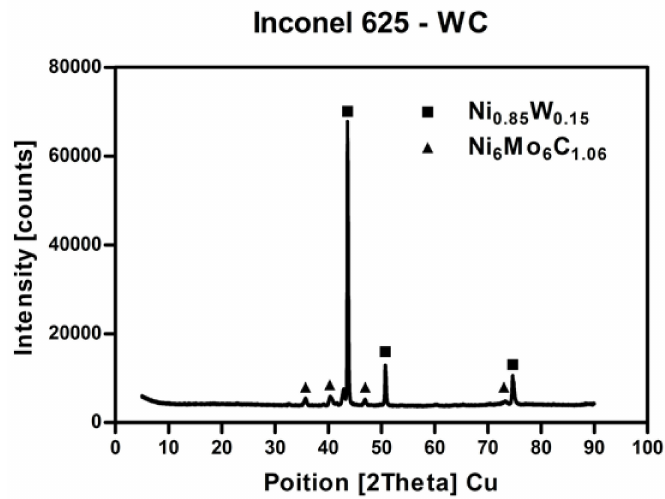
Figure 3. X-ray diffraction analysis of obtained Inconel 625–WC